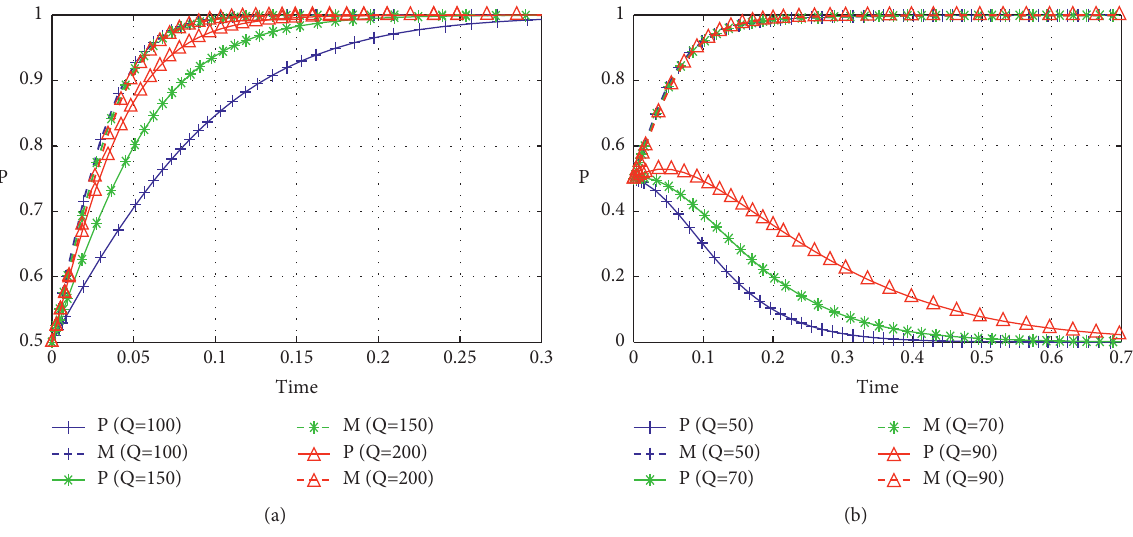
Figure 5: The impacts of the churning of basic customers in different cases. (a) Case 1. (b) Case 2.